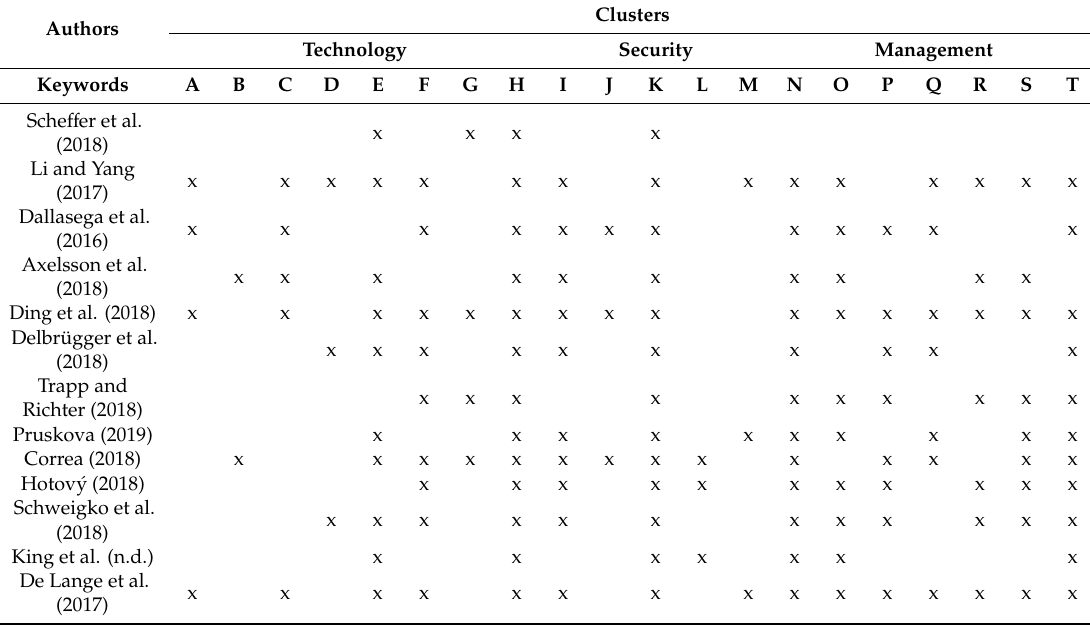
Table 10. Clustered topics discussed in 20 targeted papers (conference papers).